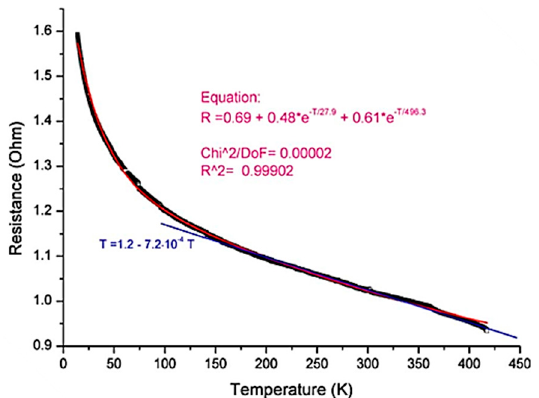
Figure 11. Resistance–temperature curve of the cryogenic sensor obtained by di Bartolomeo [51]. Copyright © 2009 American Institute of Physics.